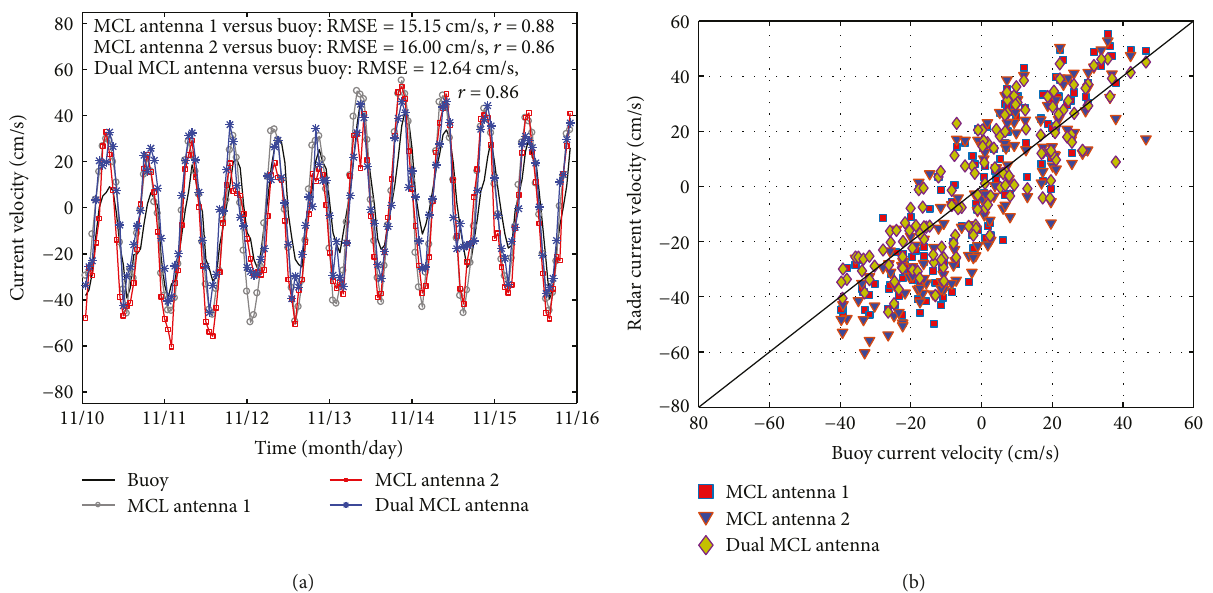
Figure 7: Radial current velocity comparisons. (a) Time series of the buoy-derived radial current velocity and that derived by LONH radar site with the MCL antenna 1, MCL antenna 2, and the dual MCL antenna system. Statistics, correlation coe ffi cient ( r ), and root-mean-square error ( RMSE ) of each radar-ADCP current comparison pairs are shown on the top of (a). (b) Scatter plot of the radial current